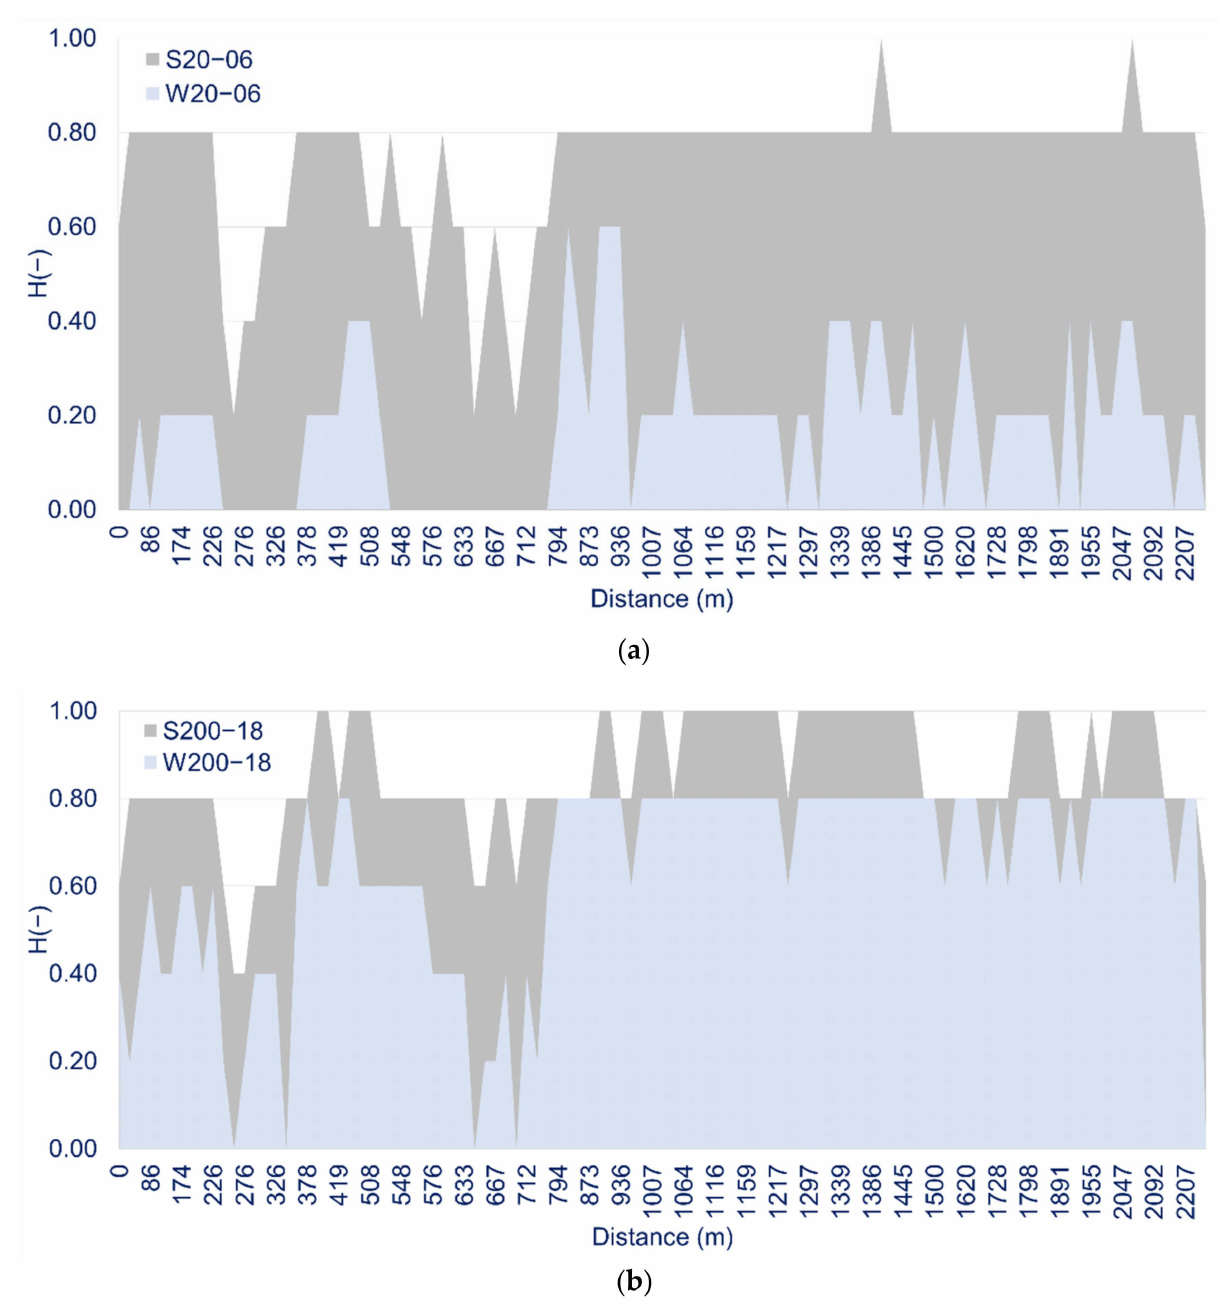
Figure 11. Calculated flood hazard (H) along Koropouli Street for 4 indicative scenarios: ( a ) Scenarios S20-06 and W20-06 for T = 20 y and t = 6 h. ( b ) Scenarios S200-18 and W200-18 for T = 200 y and t = 18